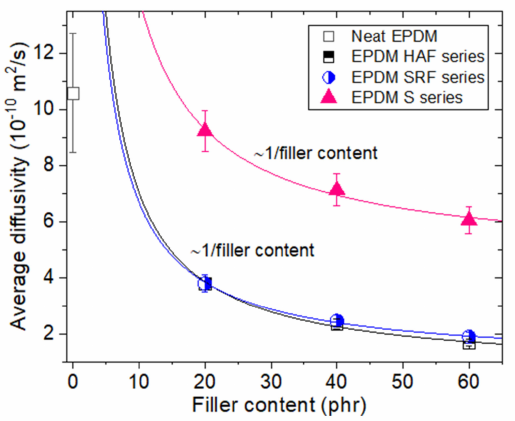
Figure 7. Average diffusivity versus filler content for neat EPDM and EPDM composites blended with